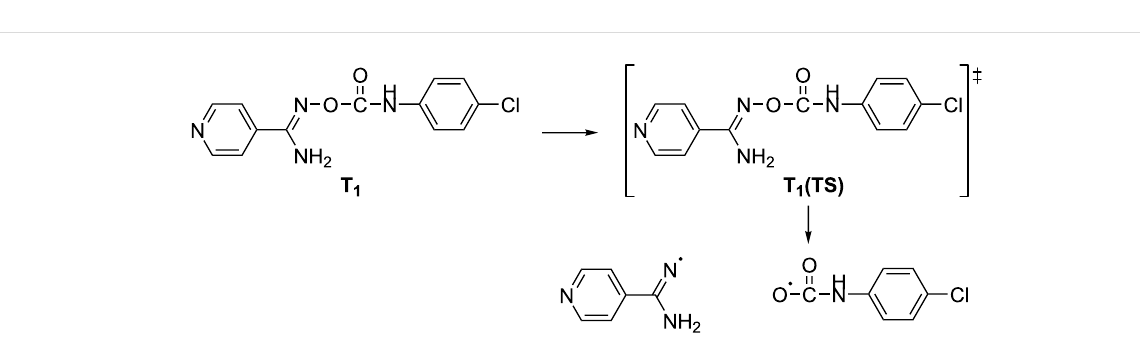
Scheme 2: Photodissociation reaction of the derivative 12 in the T 1 state and the formation of ground state radicals.